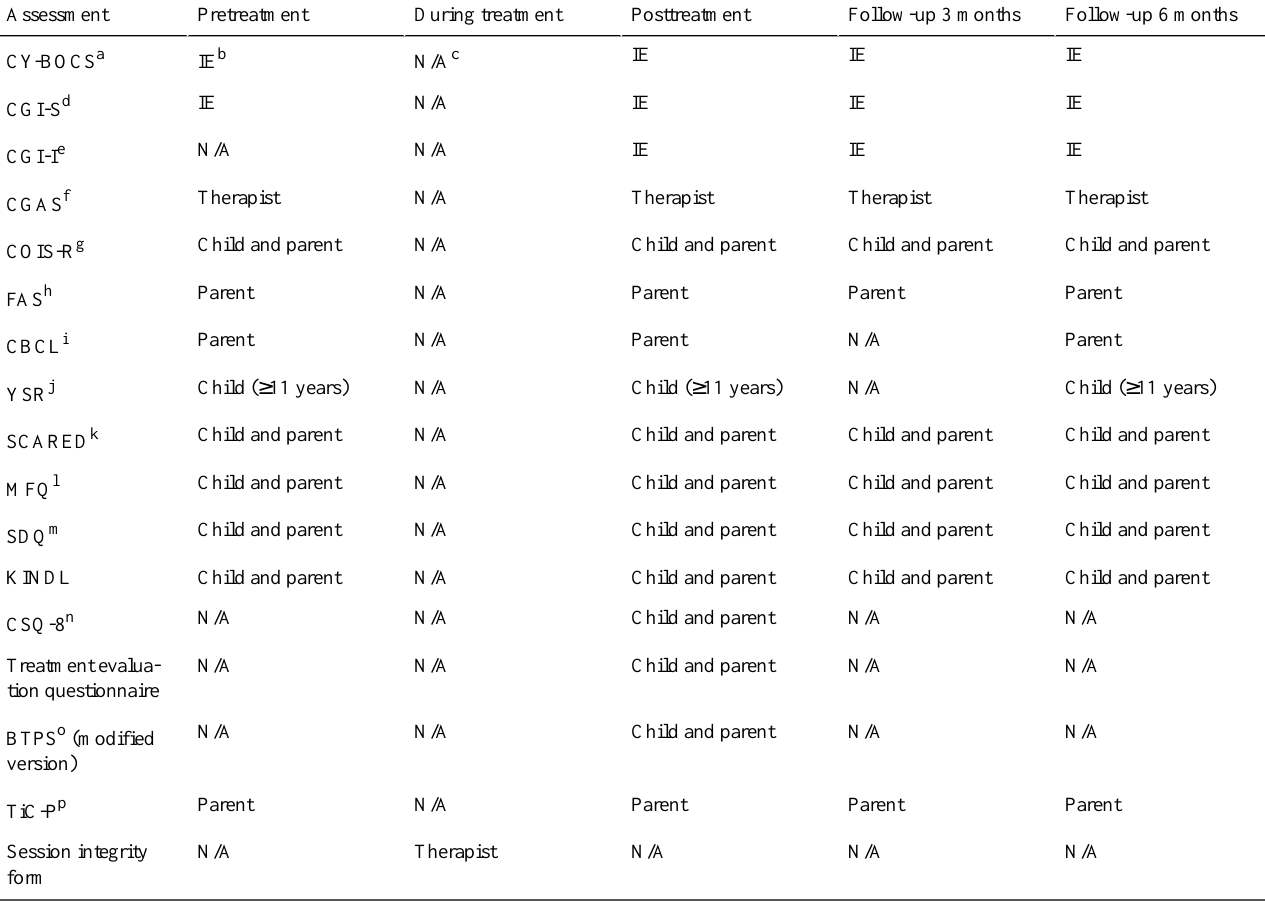
Table 1. Overview of